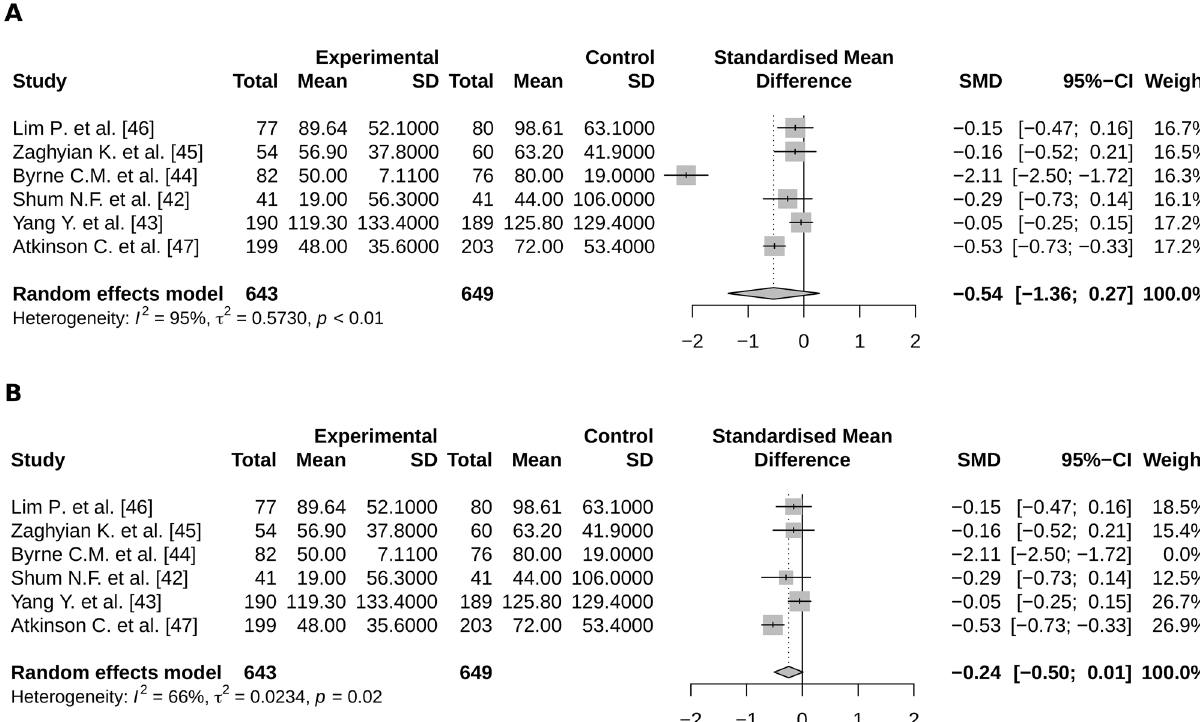
Figure 5. Meta-analysis of the time to first bowel movement according to a treatment by chewing gum ( A ) with and ( B ) without the outlier (R software, 3.6.3, https:// www.R- proje ct.